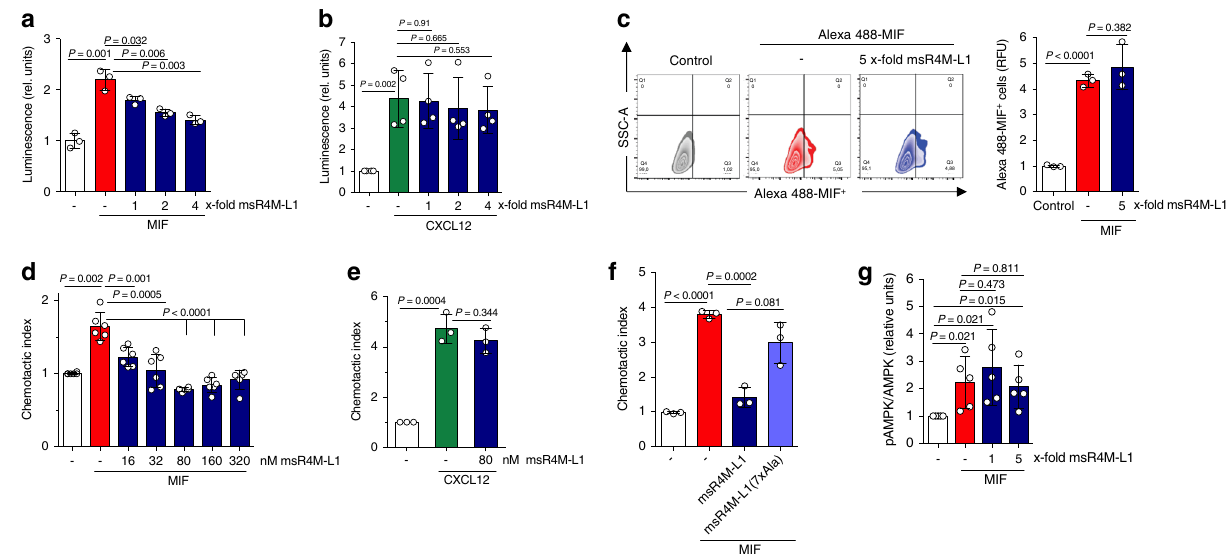
Fig. 3 msR4M-L1 selectively inhibits MIF-triggered CXCR4 activity, but spares the MIF/CD74 axis. a , b MIF ( a ) but not CXCL12 ( b ) binding to and signaling through human CXCR4 in an S. cerevisiae system is attenuated by msR4M-L1 in a concentration-dependent manner. The molar excess of competing msR4M-L1 over MIF or CXCL12 is indicated. CXCR4 binding/signaling is read out by LacZ reporter-driven luminescence. c A 5-fold molar excess of msR4M-L1 does not interfere with binding of Alexa 488-MIF to CD74 expressed on HEK293-CD74 transfectants as measured by fl ow cytometry. Left, shift of CD74 transfectants following Alexa 488-MIF binding (control indicates background); right, quanti fi cation of three independent experiments. d , e Chemotactic migration (Transwell) of primary mouse spleen B lymphocytes elicited by 16 nM MIF ( d ) or CXCL12 ( e ) as chemoattractant and inhibitory effect of msR4M-L1. msR4M-L1 dose-dependently inhibits MIF-mediated chemotaxis ( d ), but the optimal inhibitory dose of 80 nM does not affect CXCL12-elicited chemotaxis ( e ). f msR4M-L1 analog msR4M-L1(7xAla) does not inhibit MIF-mediated chemotaxis. msR4M-L1(7xAla) was applied at a concentration of 80 nM. g msR4M-L1 does not interfere with MIF-triggered AMPK signaling in the human cardiomyocyte cell line HCM. MIF was